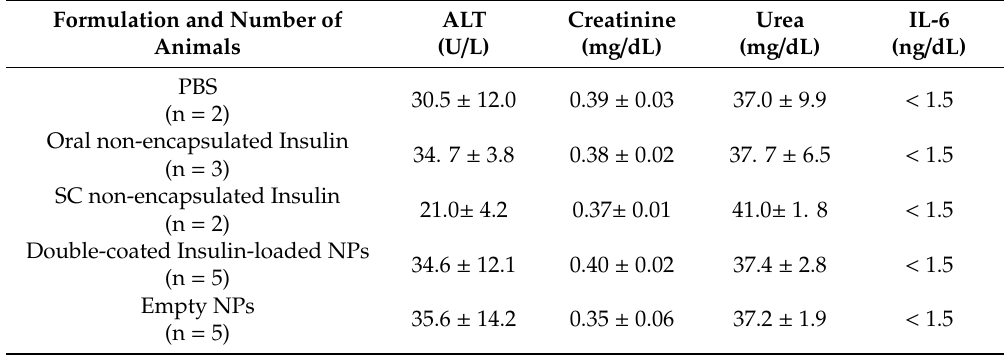
Table 5. Serum levels of ALT, creatinine, urea, and IL-6, of the rats of the di ff erent groups. The results were presented regarding the mean ±